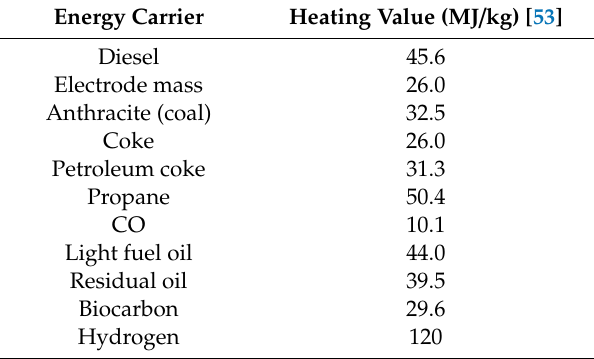
Table A4. Energy content of carriers to the industry located within Mo Industrial